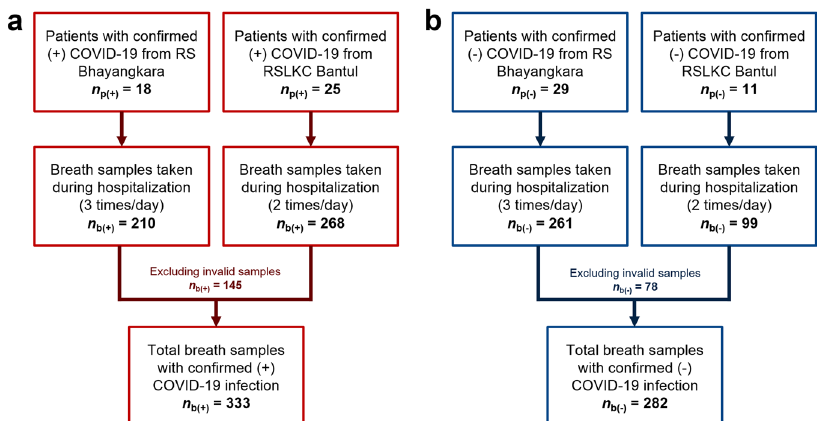
Fig. 4 Exhaled breath collection procedure performed in the pro fi ling test. Breath sampling procedure comprising patients with RT-qPCR- con fi rmed a positive ( n p( + ) ) and b negative ( n p( − ) ) COVID-19 infection in two hospitals (i.e., Bhayangkara General Hospital in Sleman District (RS Bhayangkara) and Bambanglipuro COVID-19 Special Field Hospital in Bantul District (RSLKC Bantul)). Both are located in the Special Region of Yogyakarta, Indonesia. The total breath samples were obtained by excluding the invalid ones measured by GeNose C19, in which the total con fi rmed positive and negative COVID-19 samples were n b( + ) = 333 and n b( − ) = 282,